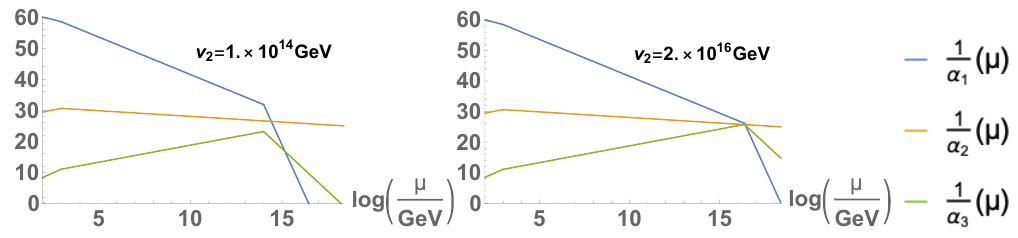
Figure 2 . Running coupling constants of the MSSM in model A, assuming m soft =